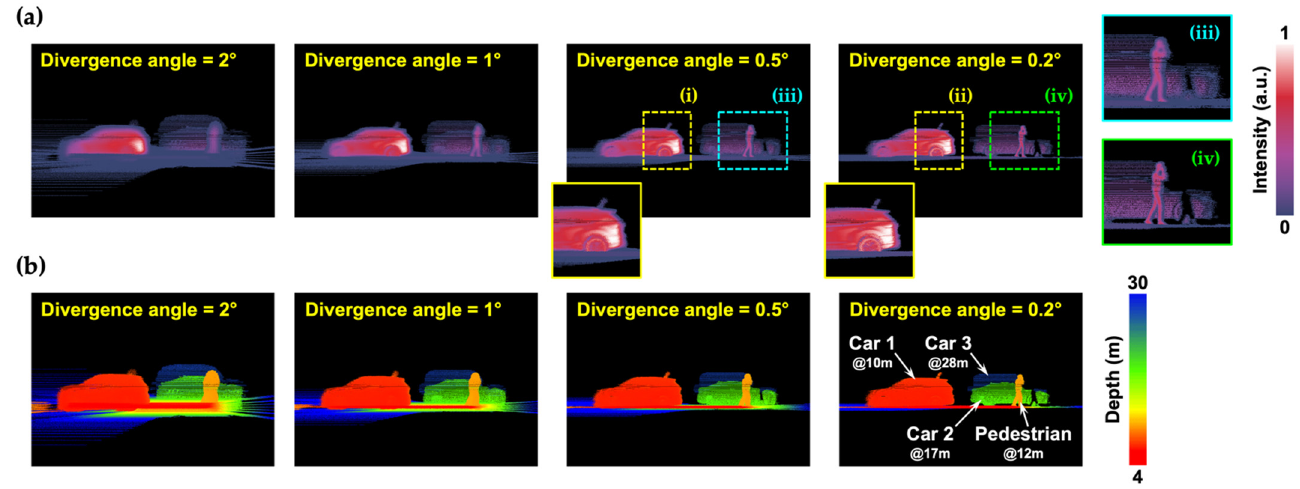
Figure 10. Simulated point cloud results of ( a ) scalar field intensity and ( b ) corresponding depth perception. Insets of ( a ): Some zoom-in details observed in the result of scalar field intensity. ( i,ii ) As the beam divergence angle is shrunk down to 0.2 ◦ , relevant details of rear tire, wheel disk, and even the taillight of Car 1 can be identified. ( iii,iv ) The narrower beam divergence, the clearer the pedestrian’s contour. Meanwhile, a pedestrian’s shadow can be observed, emerging on Car 2.